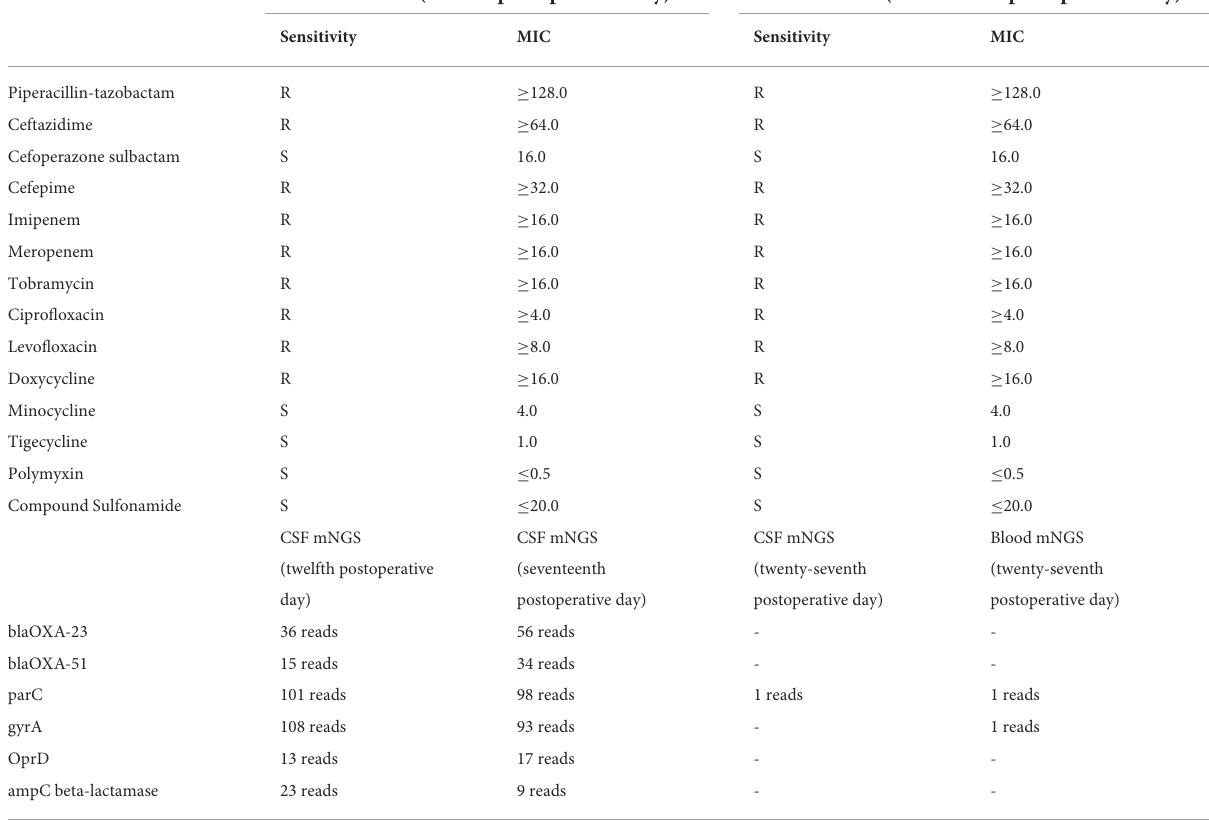
TABLE 1 Drug resistance results of culture and